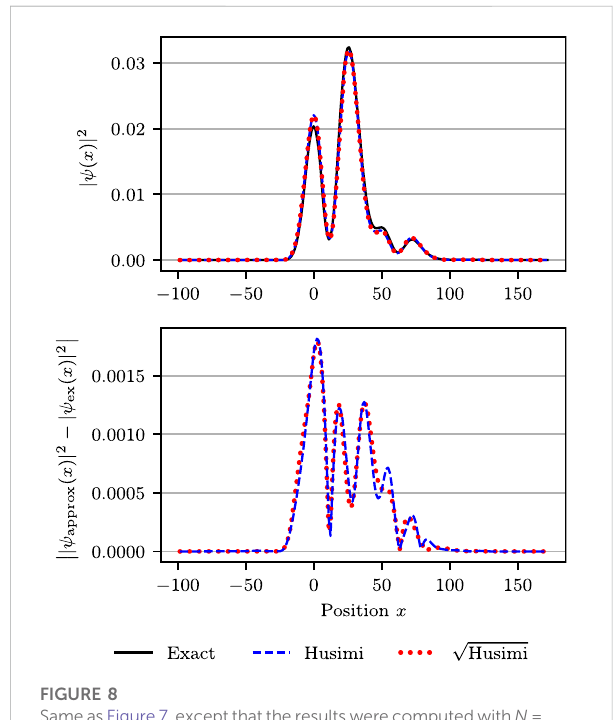
FIGURE 8 SameasFigure7,exceptthattheresultswerecomputedwith N = 100 · 2 14 ≈ 1.6 · 10 6 trajectories and, therefore, are